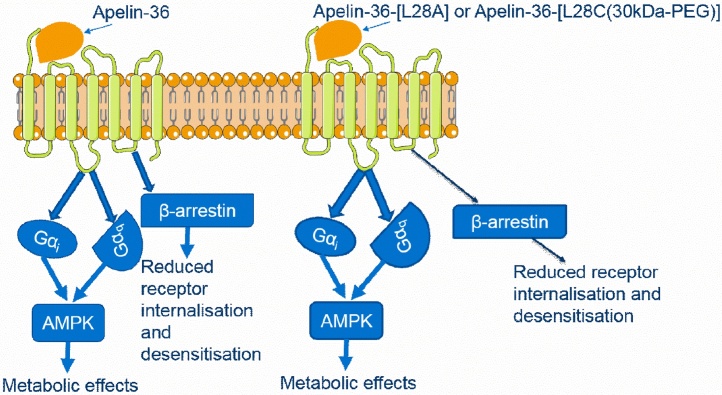
Proposed signalling cascade activated by apelin-36-[L28A] and apelin-36-[L28C(30kDa-PEG)] upon binding to the apelin receptor. On the left, apelin-36 recruits Gαi and Gαq signalling following receptor binding resulting in the activation of AMP-dependent kinases. However, it will also activate β-arrestin recruitment, which will result in receptor desensitisation and degradation or recycling back to the cell surface. On the other hand, apelin-36-[L28A] and apelin-36-[L28C(30kDa-PEG)] on the right recruits Gαi and Gαq signalling resulting in the activation of AMP-dependent kinase group of enzymes which mediates the downstream beneficial metabolic effects. There is reduced receptor internalization and desensitization, which is likely to prolong the agonists activity of the two peptides compared to apelin-36.